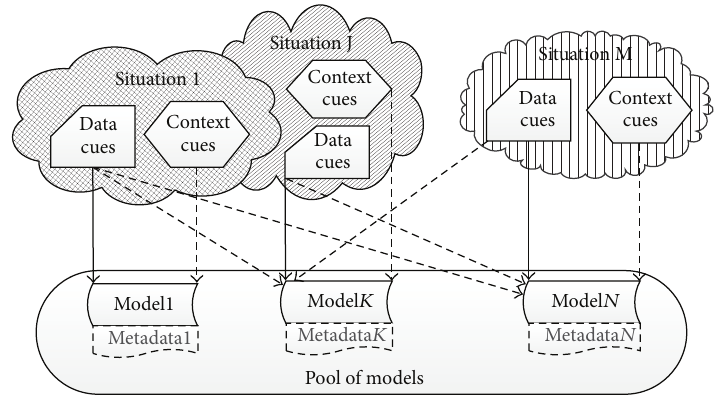
Figure 1: Modelling situation-dependency scenario; dashed lines denote optional